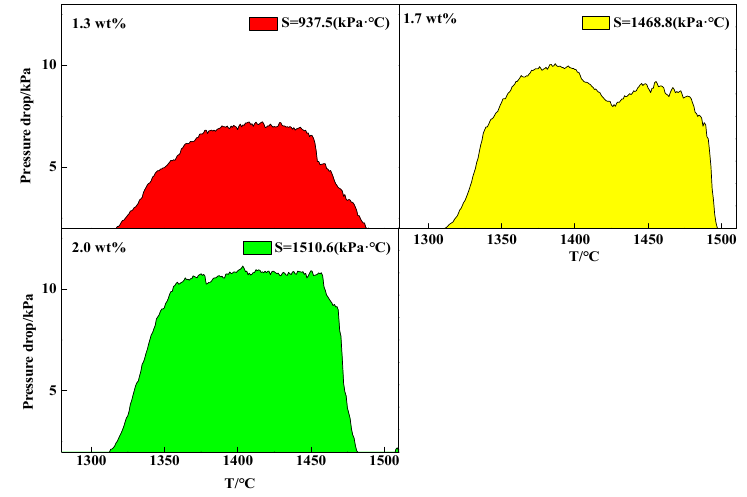
Figure 10. Effect of MgO on S-value of high basicity sinter Figure 10. E ff ect of MgO on S-value of high basicity